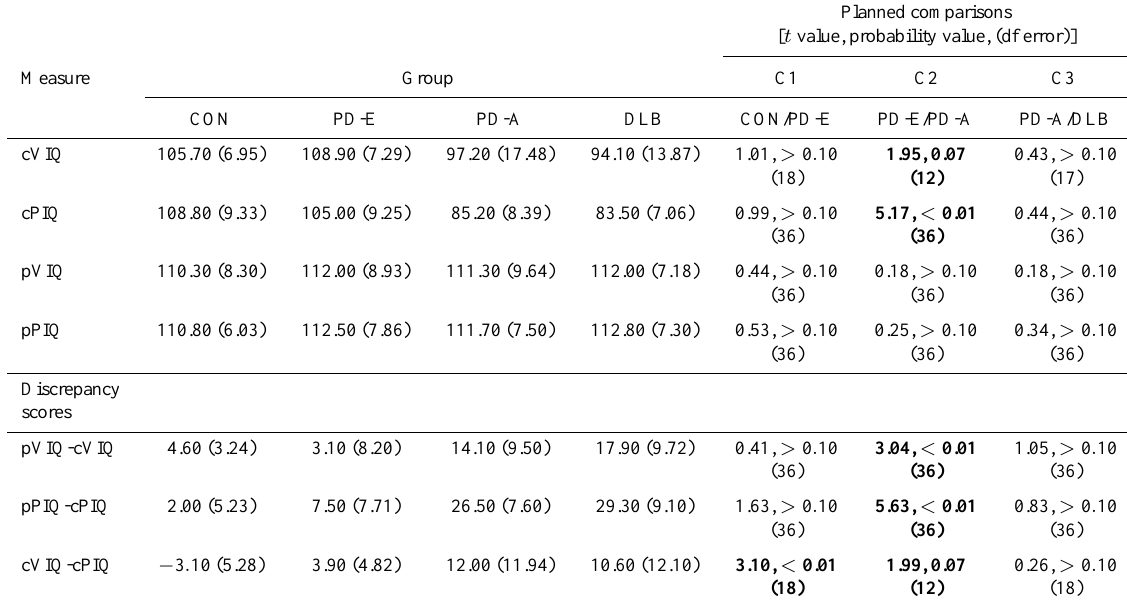
Means, standard deviations, and planned comparisons for premorbid and current IQ estimates, and derived discrepancy scores